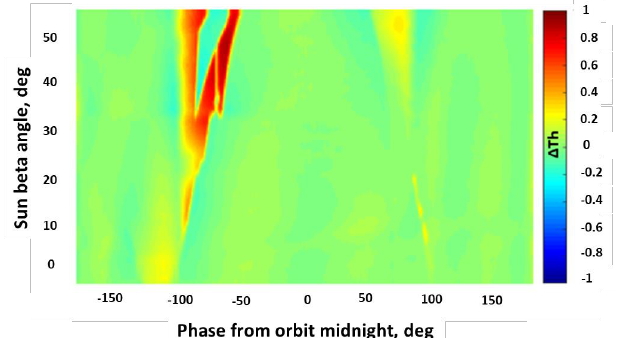
Figure 5. The hot load correction table for channel 10.65 V at yaw 0°, during the post-boost time.